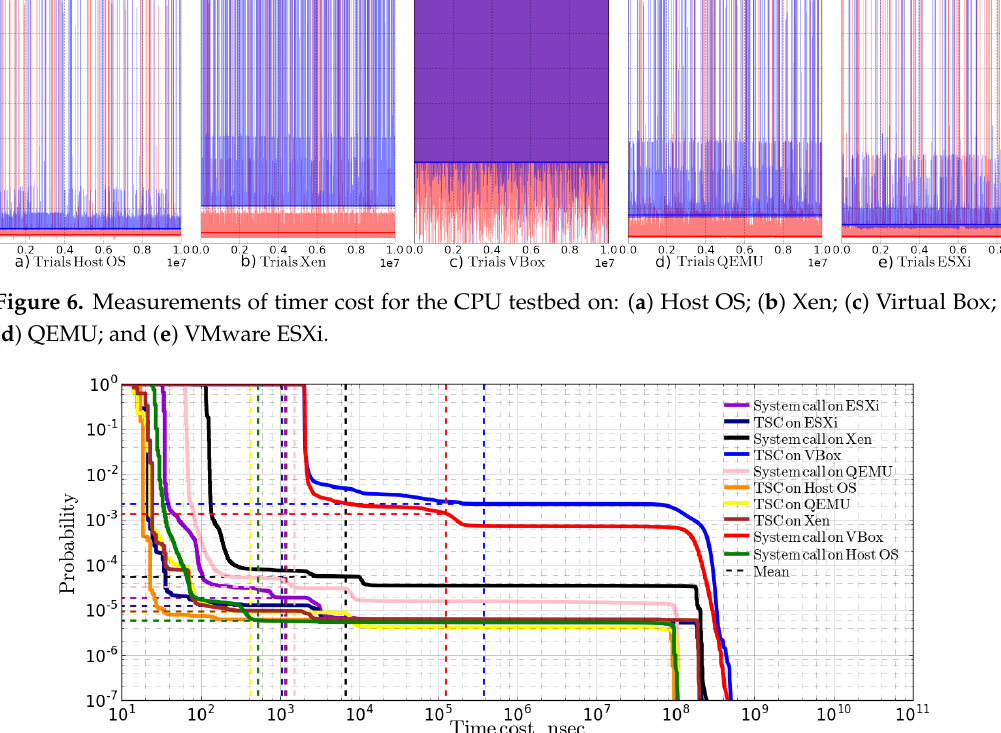
Figure 7. CCDF representation of measurements of time cost for the CPU